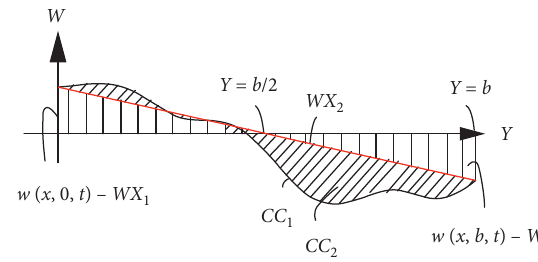
Figure 6: The second interpolation function on the plane ( Y, Z ) .